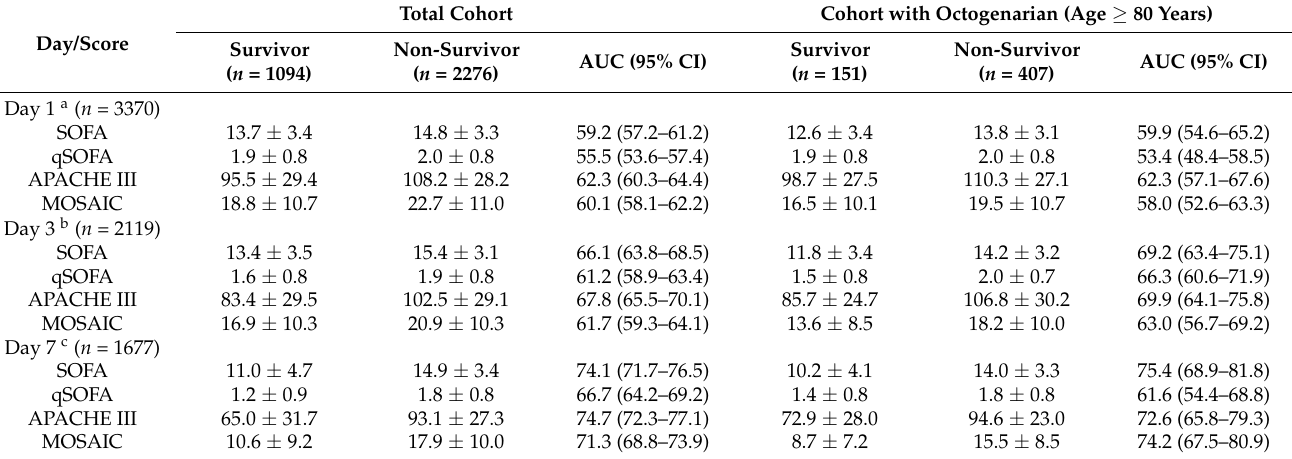
Table 3. Performance of the scoring systems in predicting ICU mortality in the entire cohort and in patients older than 80